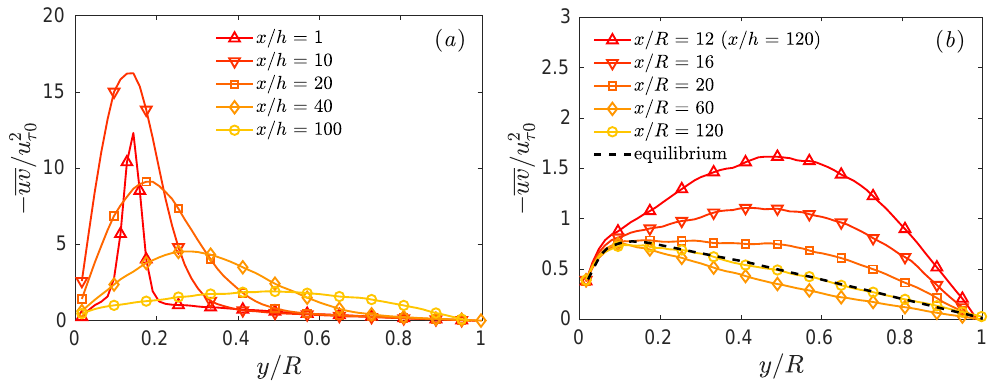
Figure 7. Distribution of − uv at various locations downstream of a square bar roughness element for h / R = 0.1. ( a ) Near field. ( b ) Far